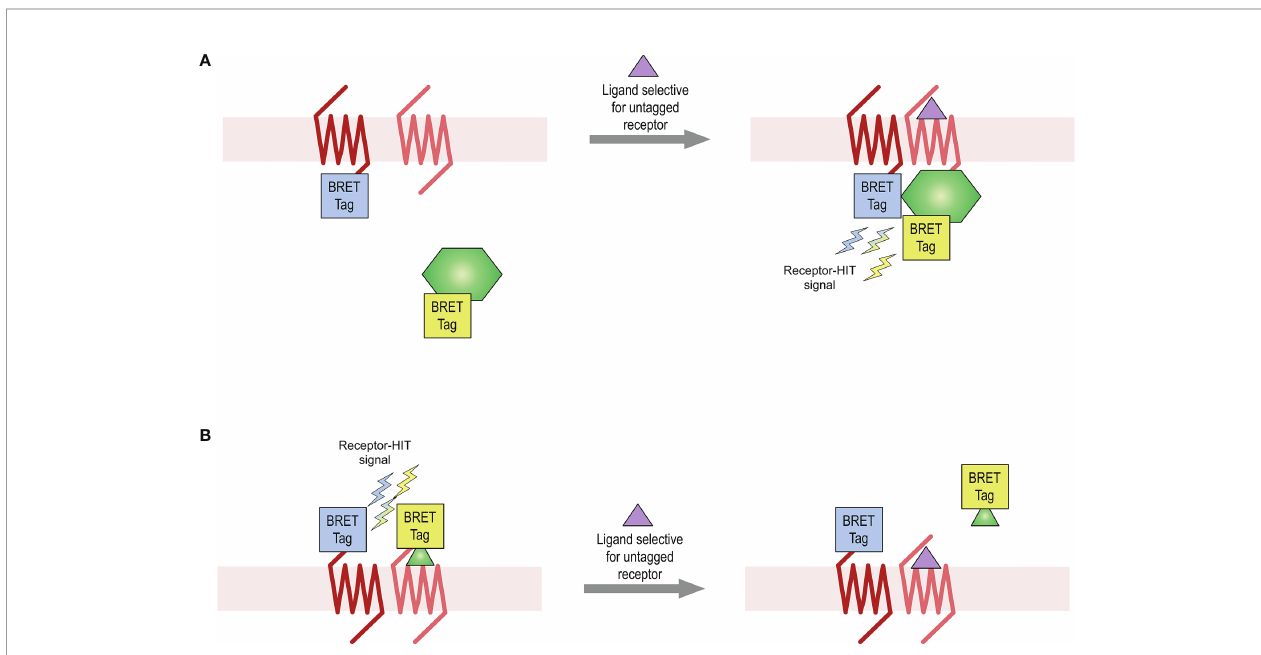
FIGURE 1 | Receptor-HIT assay used for detection of receptor heteromers. The Receptor-HIT assay allows for monitoring of receptor interactions through recruitment of a labelled intracellular protein (A) or ligand (B) . In this system using BRET as the proximity assay, one receptor is fused to one BRET tag (either a luciferase or a fl uorophore) while the second receptor remains untagged. The interacting biomolecule is fused with the complementary BRET tag. A BRET signal upon addition of a ligand selective for the untagged receptor is indicative of receptor